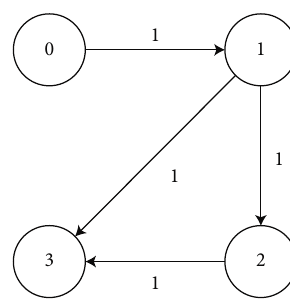
Figure 5: Topology of the graph G